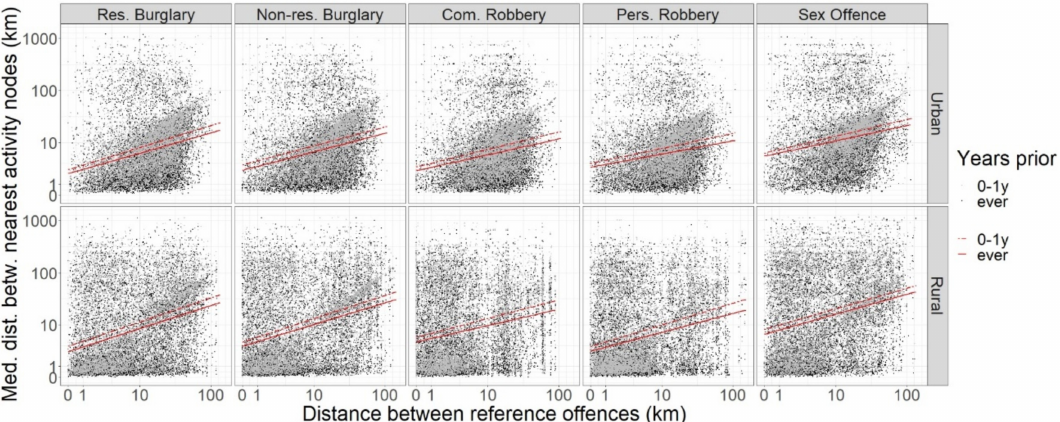
Figure 7. Median distance between nearest activity nodes by distance between reference